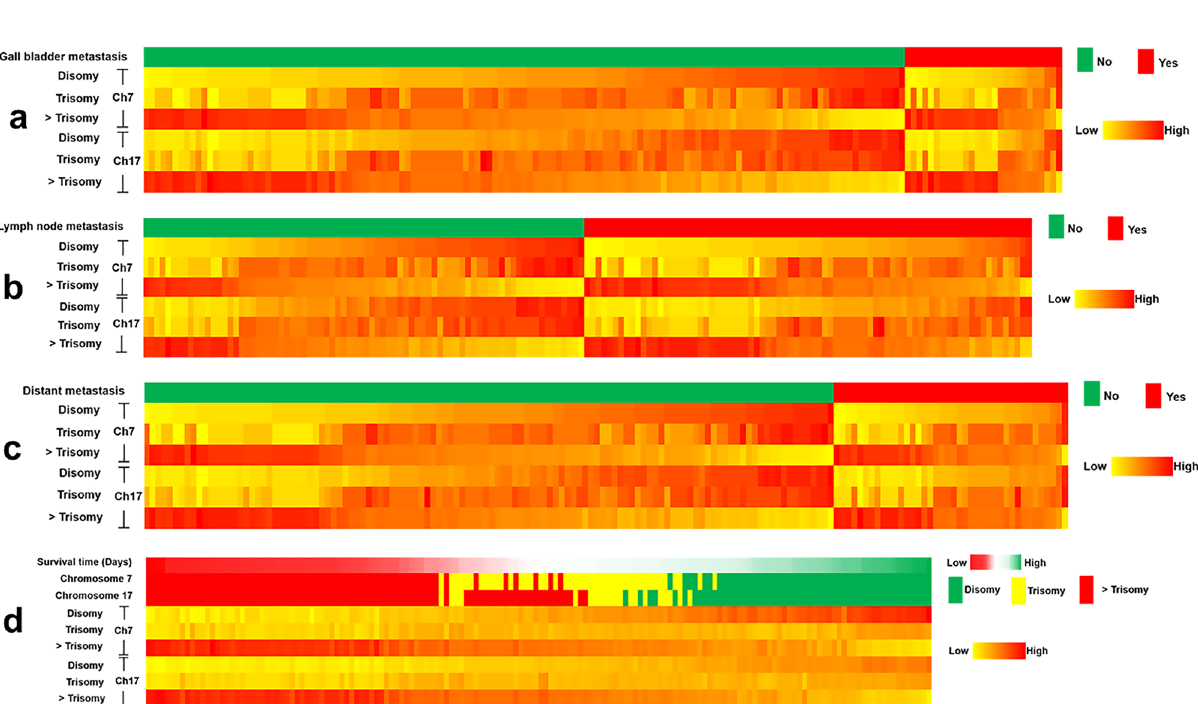
Figure 3. Heatmap analysis showing the proportion of C7 and 17 disomy and polysomy in patients with gall bladder metastasis ( a ), lymph node metastasis ( b ), distant metastasis ( c ) and survival time ( d